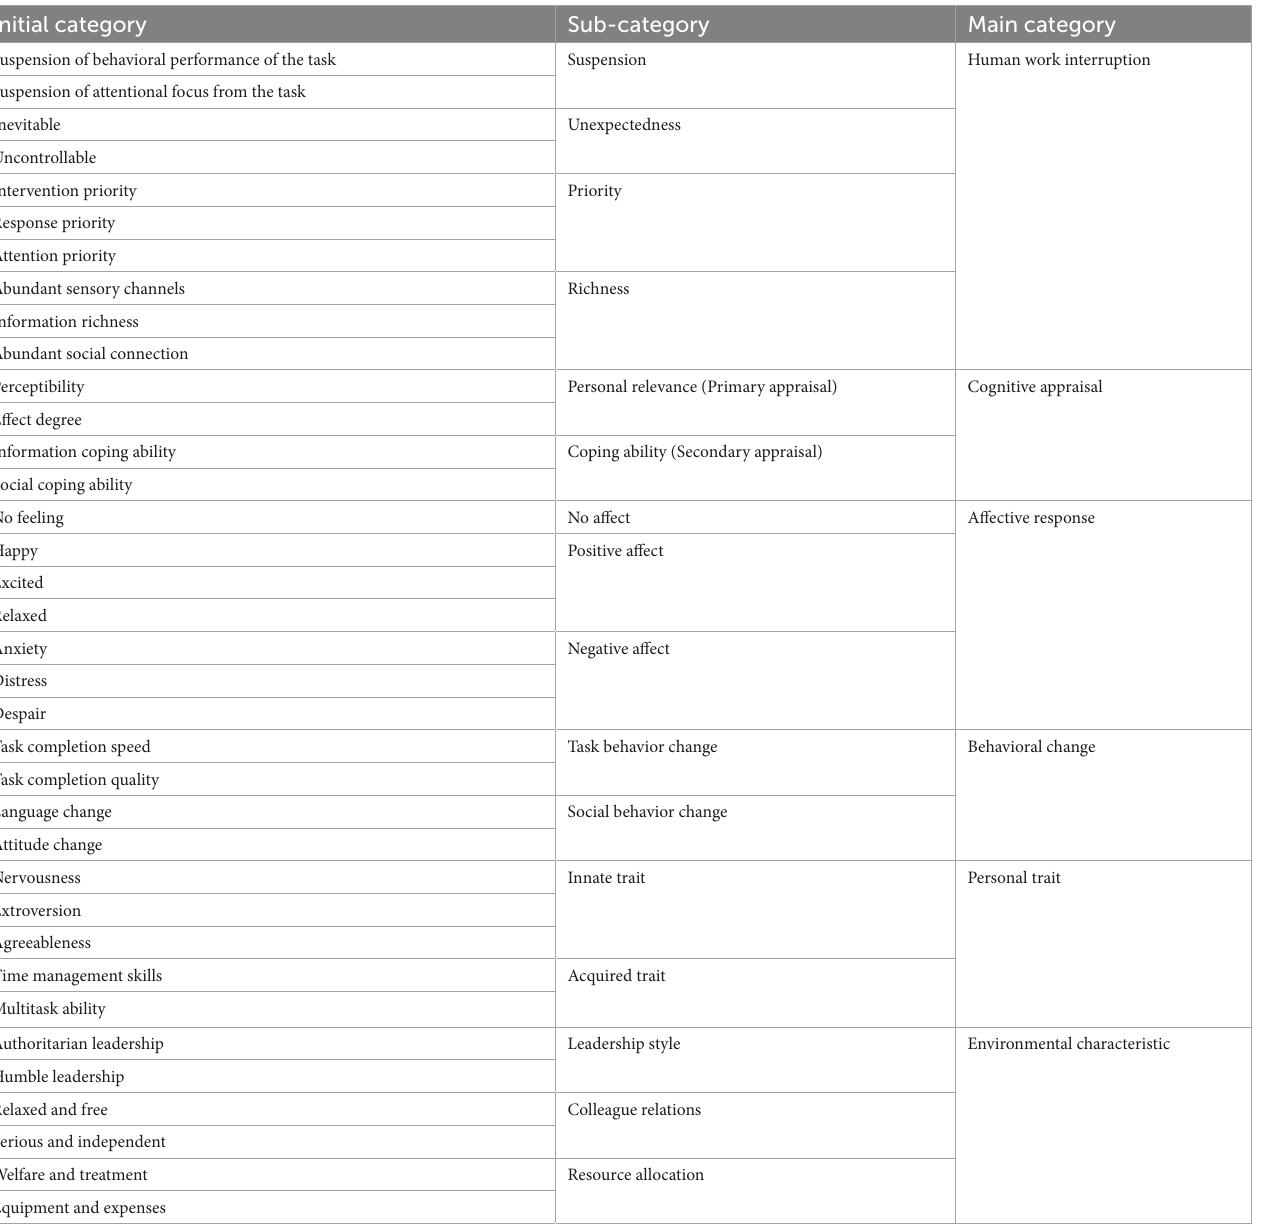
TABLE 2 Human work interruptions axial